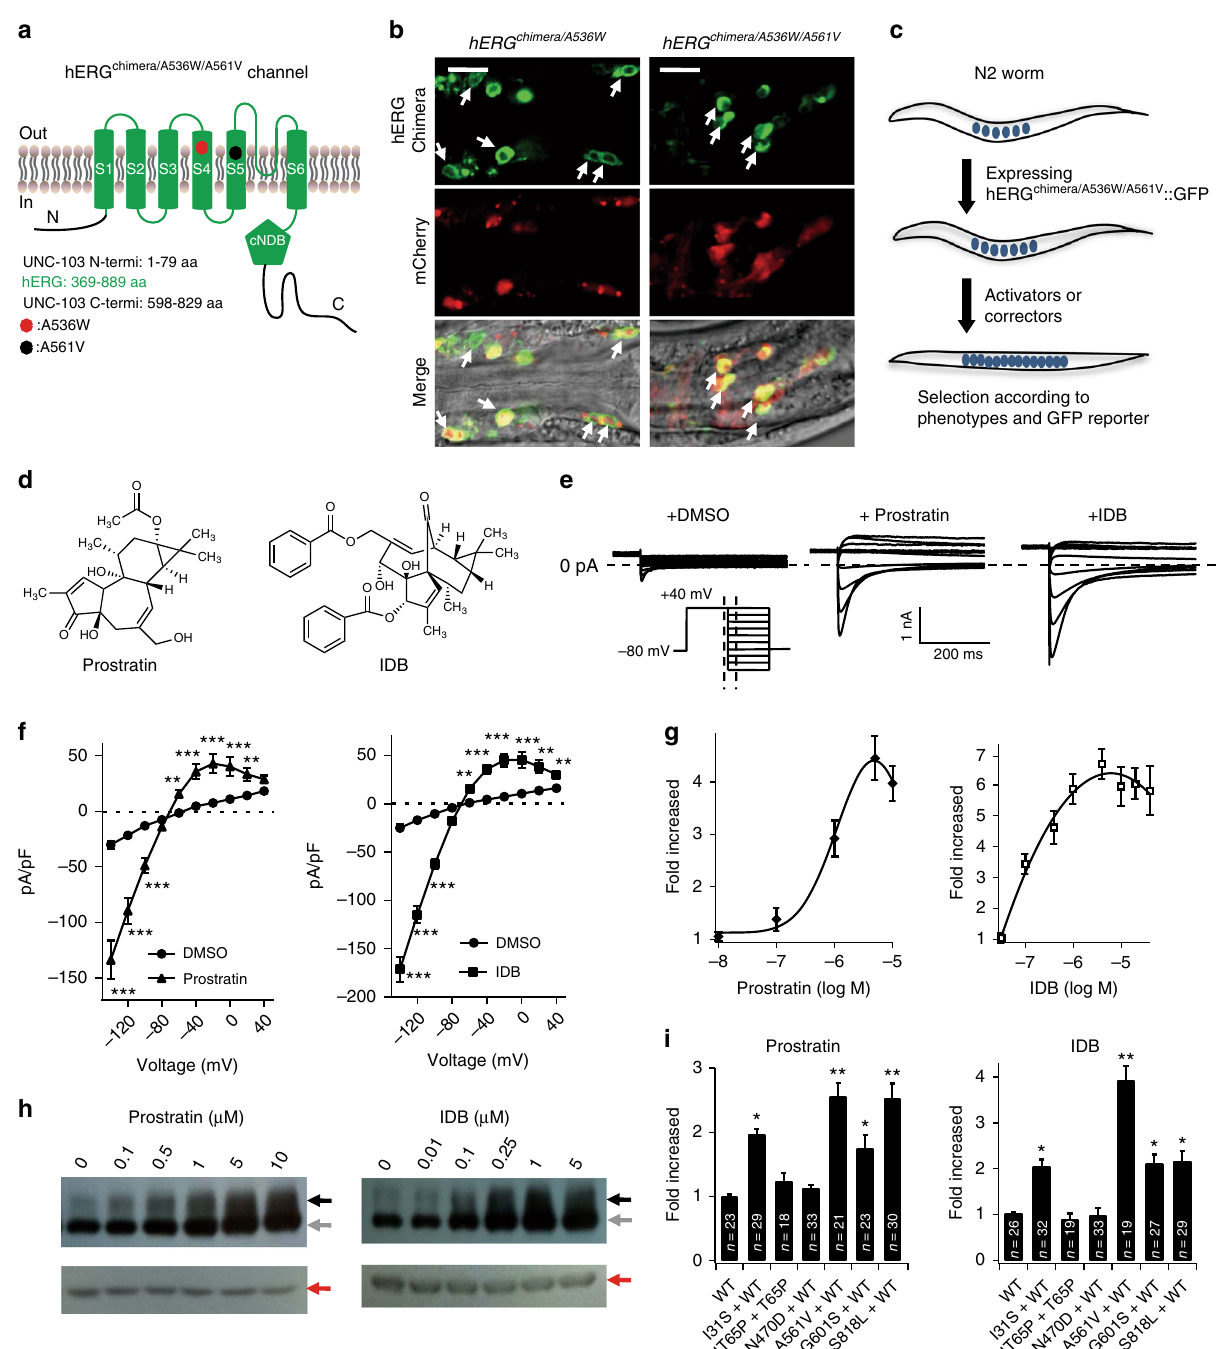
Fig. 3 Small-molecule screens identify functional correctors of hERG A561V . a Schematic illumination of construction of hERG chimera/A536W/A561V . Mutations A536W and A561V are indicated by a red and a black circle, respectively. aa amino acids. b Localization of hERG chimera/A536W:: GFP and hERG chimera/A536W/A561V ::GFP expressed in C. elegans neurons. White arrows indicate head neurons. Scale bar, 10 μ m. c Schematic illumination of screening strategy for the discovery of functional correctors. Brie fl y, we fi rst searched for compounds that caused locomotive and egg-laying defects, and then the candidate compounds were further selected according to surface expression of hERG chimera/A536W/A561V ::GFP proteins. d Molecular formulas of Prostratin and IDB. e , f Representative whole-cell currents ( e ) and I / V curves ( f ) of hERG WT -hERG A561V channels expressed in HEK293T cells treated with DMSO ( n = 26), 3 µ M Prostratin ( n = 21) or 2 µ M IDB ( n = 25). g Dose-dependent effects of Prostratin and IDB on the current density of hERG WT - hERG A561V channels recorded at a membrane potential of − 140 mV. About 20 cells per dose were recorded and analyzed. h Effects of Prostratin and IDB on the protein traf fi cking of hERG WT -hERG A561V channels. Black, gray, and red arrows indicate 155 kD, 135 kD bands of hERG proteins, and tubulin, respectively. i Effects of Prostratin and IDB on the current densities of LQTS-related hERG mutant channels. The ratio of hERG WT /hERG A561V was 2:1 for e , f , g , and 1:1 for h , I . The ratio of hERG WT /other hERG mutant was 1:1. All experiments were performed at least three times. Data shown are mean ± s.e.m. * P < 0.05, ** P < 0.01, *** P < 0.001 (Student ’ s t -tests for f ; one-way ANOVA Dunnett ’ s test for i